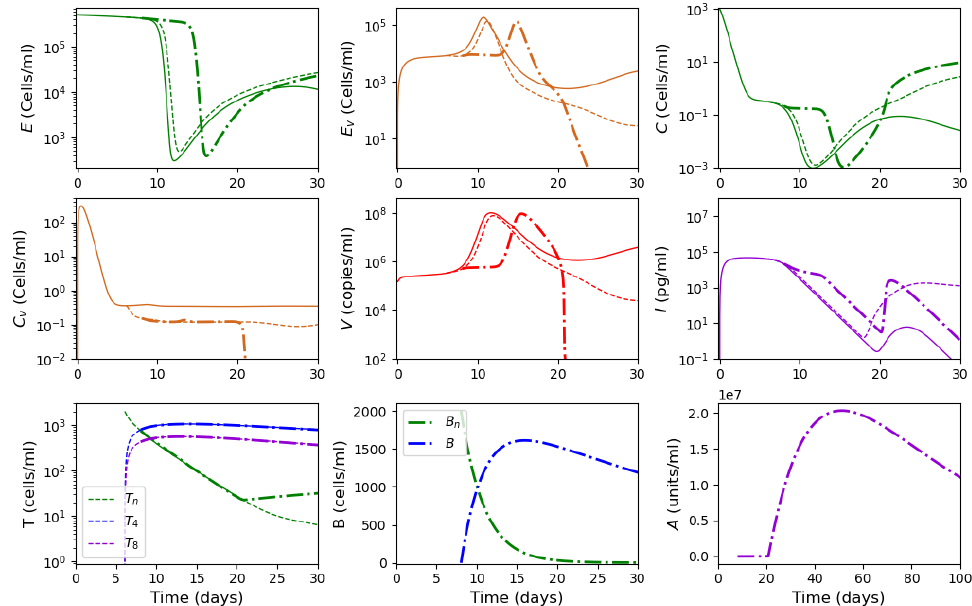
Figure 7. Numerical simulations of innate and adaptive immune responses in system (10)–(21). Notation is similar to Figure 6. A slight decrease in the parameter k 5 = 1205.62 essentially changes the dynamics of the system due to transitioning to another